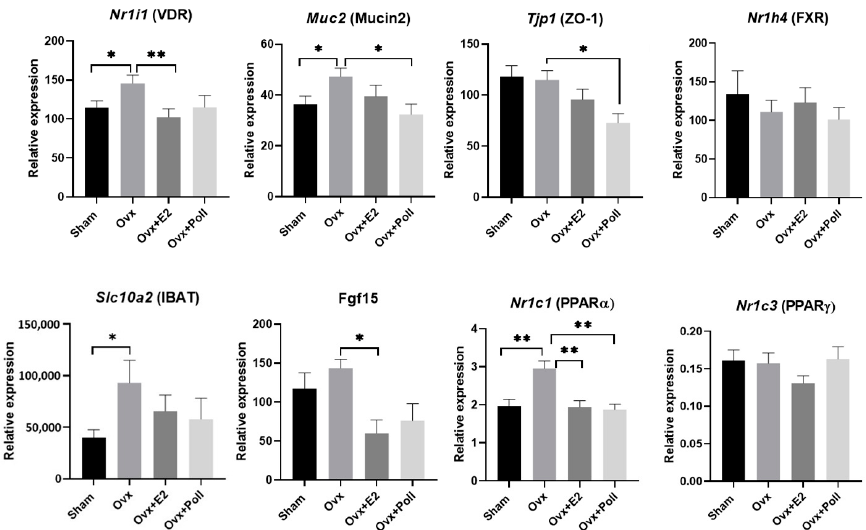
Figure 4. Effect of ovariectomy alone (Ovx) or with 17 β -estradiol (E2) supplementation (Ovx+E2) or with exposure to pollutants (Ovx + Poll) on the expression of genes encoding various nuclear receptors, mucin2, IBAT, and FGF15 in the ileum. Values are means ± SEM with n = 6–8; ** p < 0.01; * p < 0.05. Sham: Sham-operated mice.